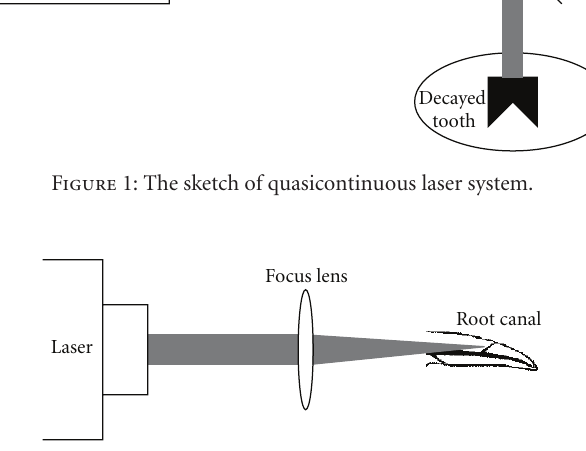
Figure 2: The sketch of Q-switched laser